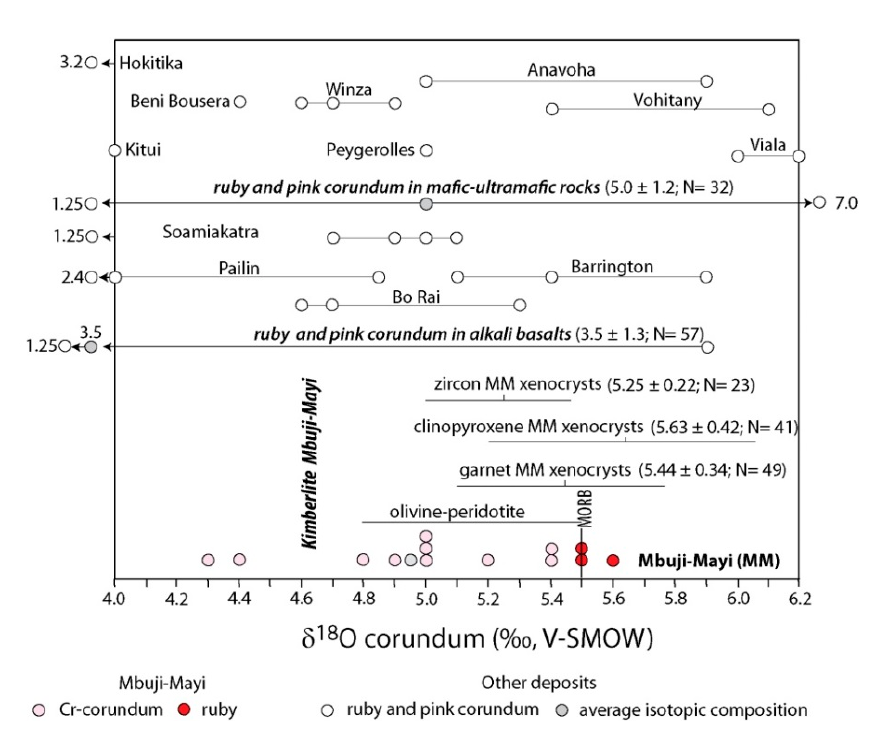
Figure 27. Oxygen isotope ranges defined for different ruby and pink corundum deposits and occurrences related to metamorphosed mafic-ultramafics and alkali basalts worldwide as well as the kimberlite at Mbuji-Mayi, modified from [84]. The data are reported in the conventional delta notation relative to V-SMOW (Vienna Standard Mean Ocean Water). The δ 18 O values for zircon, clinopyroxene, and garnet megacrysts from the Mbuji-Mayi kimberlites are from [163]. The deposits that occur in amphibolites are Anavoha and Vohitany (Madagascar), Viala and Peygerolles (France), Kitui (Kenya), and Winza (Tanzania). The Hokitika (New Zealand) and Beni Bousera (Morocco) occurrences are linked to metamorphosed M-UMR.